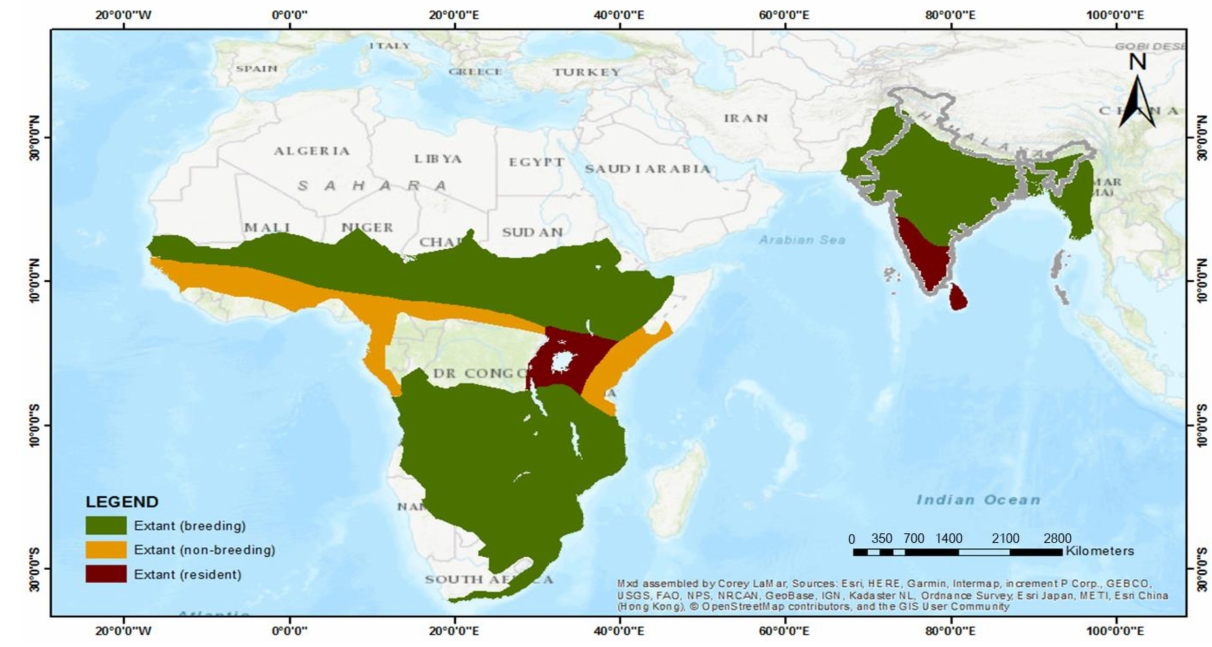
Figure 2. Extant map of Clamator jacobinus (Pied cuckoo) (Image Source: reference